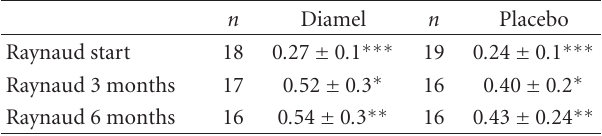
Table 6: Evolution of the insulin sensitivity index (Raynaud) in patients with the polycystic ovary syndrome. n Diamel n Placebo